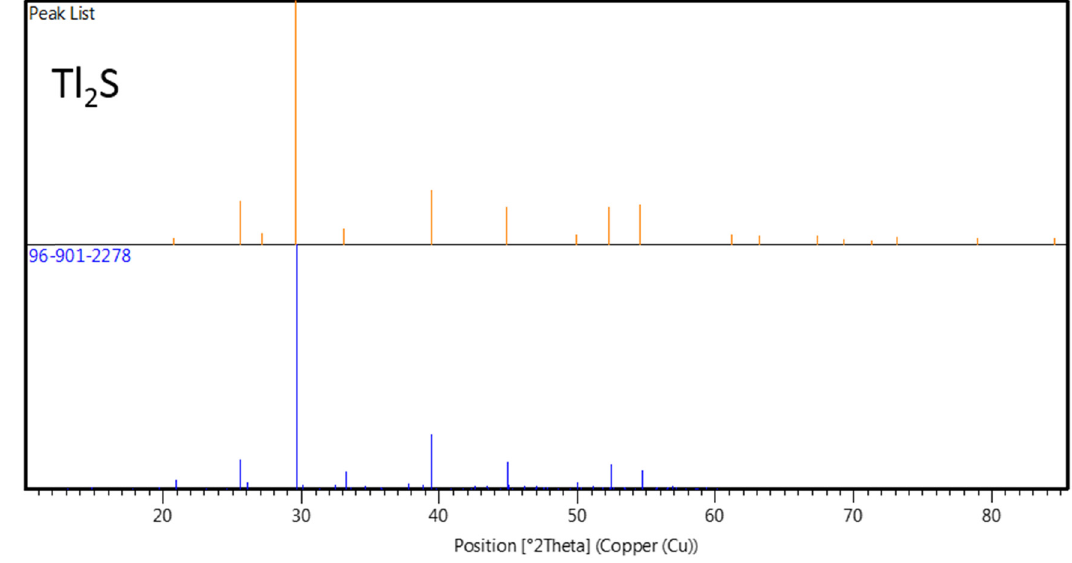
Figure A5: Standard pattern matching of Tl 2 S thin fi lms obtained by software available in X ’ Pert Highscore Di ff ractometer.